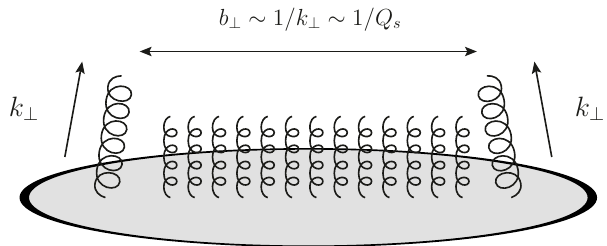
Figure 6 . Kinematic saturation: the separation between the TMD gluons is filled by multiple soft